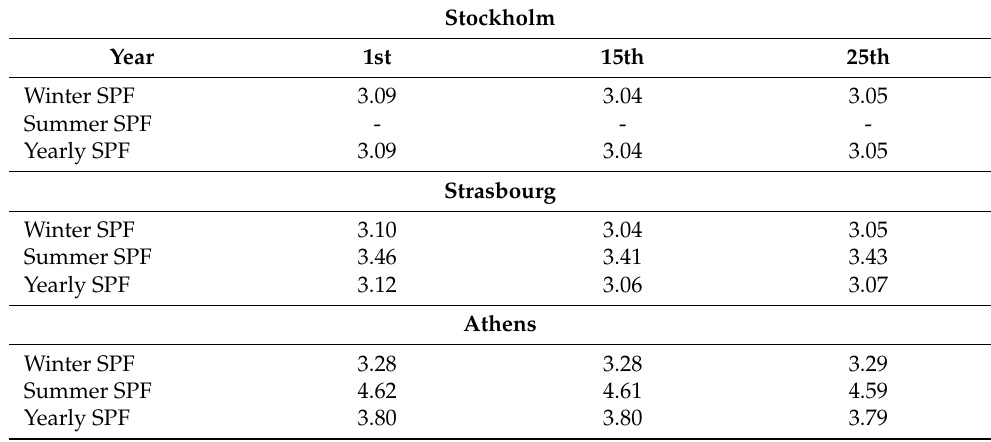
Table 13. Long-term DSHP system SPF analysis.